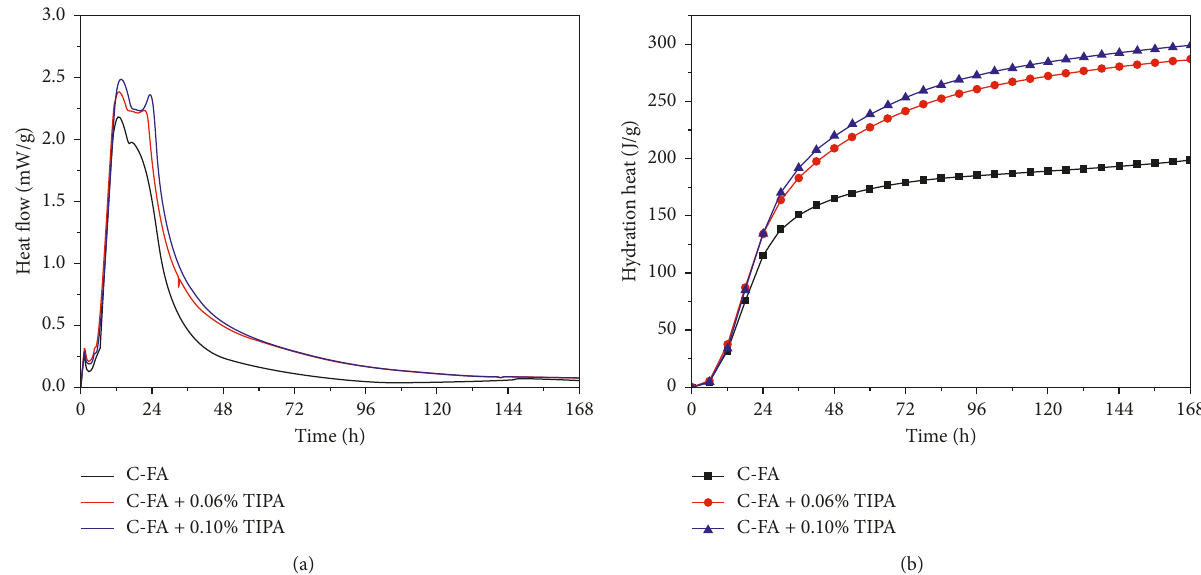
Figure 6: Hydration heat of cement-FA paste with TIPA. (a) Heat flow; (b) hydration